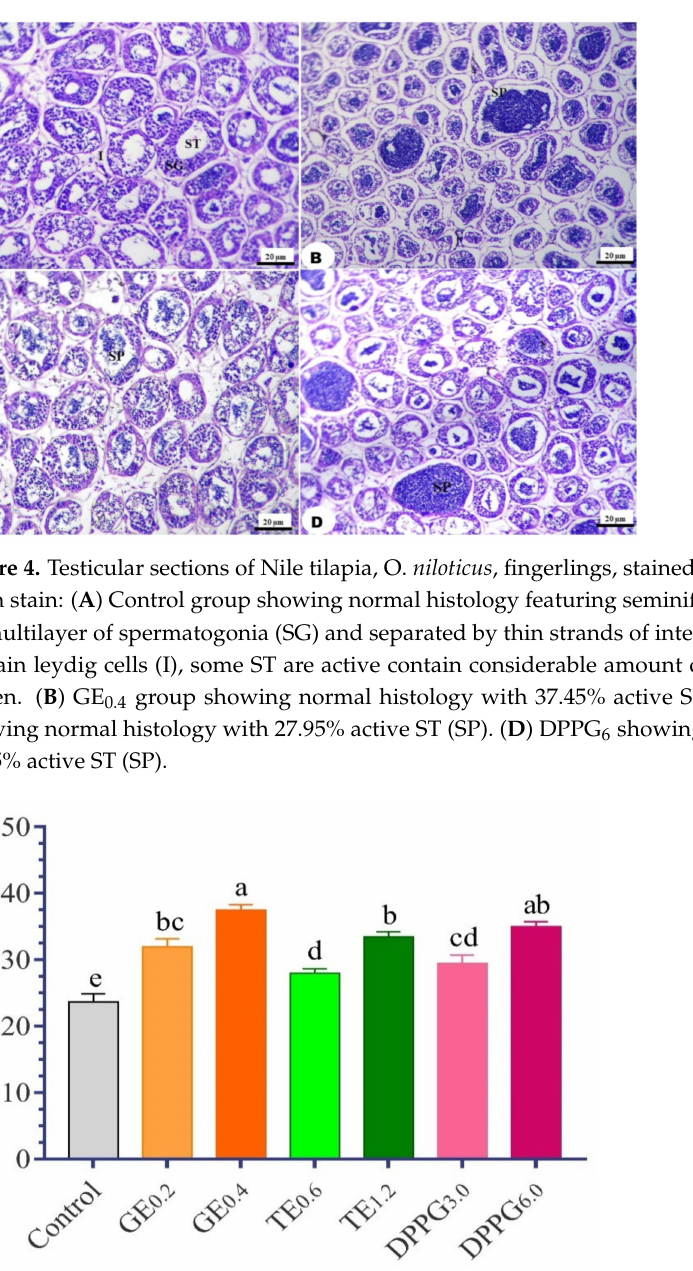
Figure 5. Effect of different antioxidants supplementation (g/kg diet) on testies percentage of active seminiferous tubules (%) of of Nile tilapia, O. niloticus . GE, ginseng extract; TT, Tribulus terrestris extract; DPPG, date palm pollen grains. (n = 5). Column superscripted by different alphabets within the same column are significantly different ( p <